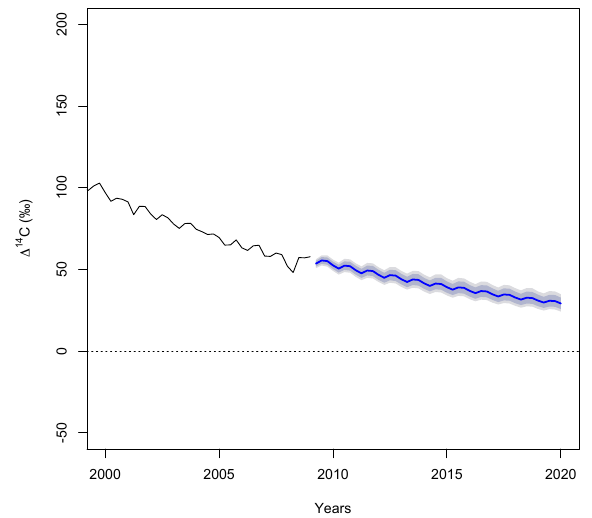
Figure 6. Forecast of the atmospheric radiocarbon data of the Northern Hemisphere zone 1 (Hua et al., 2013), including 80 and 95% prediction intervals, for the period 2010–2020 using the forecast package (Hyndman and Khandakar,